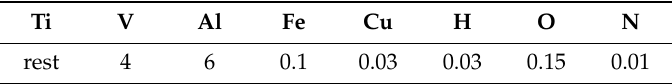
Table 2. Chemical composition of Ti6Al4V (%).